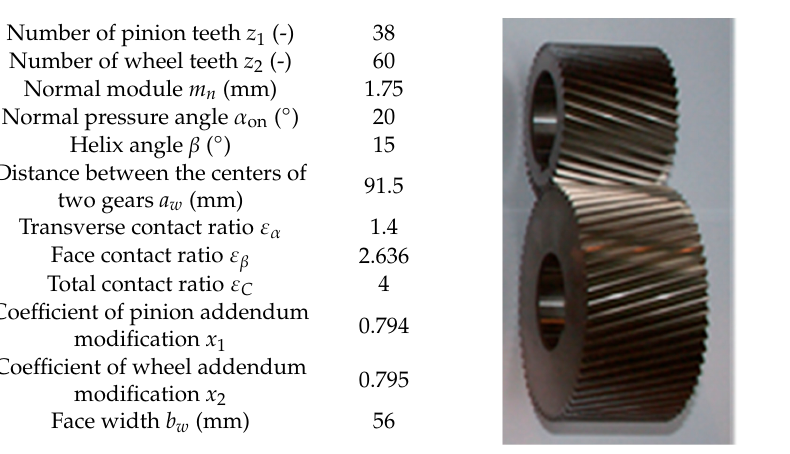
Table 1. Geometrical parameters of gear wheels used in investigations. Table 1 . Geometrical parameters of gear wheels used in investigations